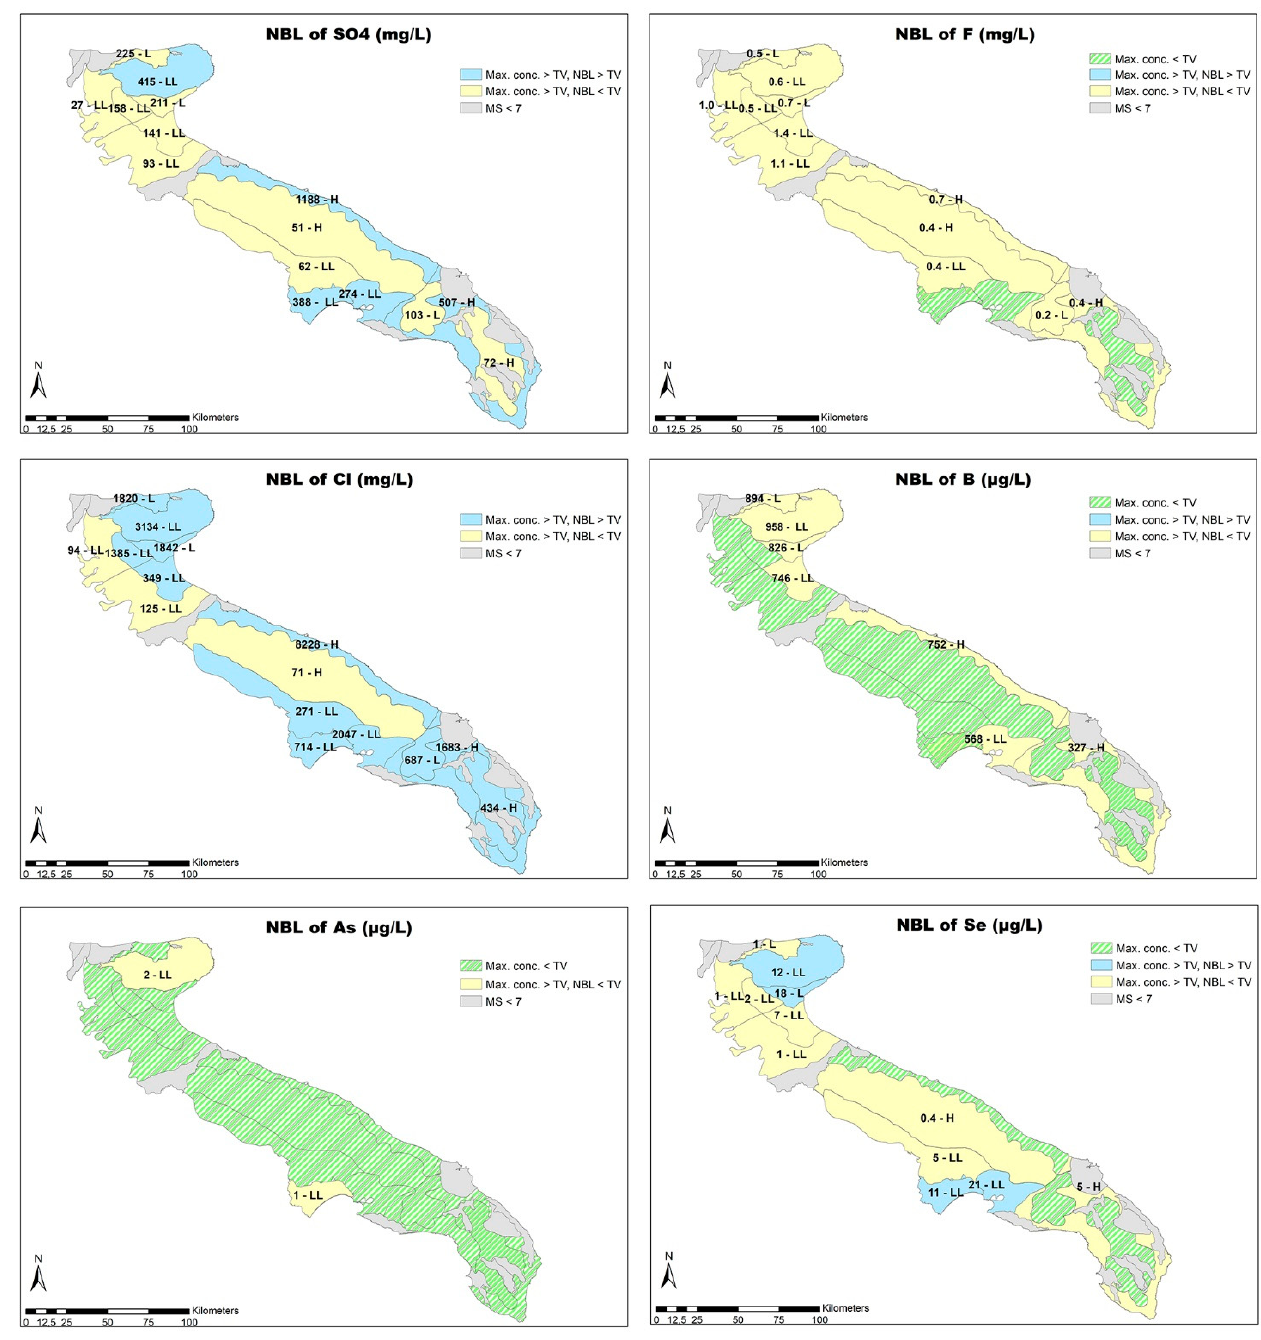
Figure 6. NBLs defined for sulfates, fluorides, chlorides, boron, arsenic and selenium at the GWBs scale and the associated confidence levels (H = high, L = low, LL = very low). The NBLs obtained for GWBs with maximum concentration observed during monitoring below TV were not shown in the figure. In grey are shown the GWBs where the NBL assessment was not performed (MS < 7).